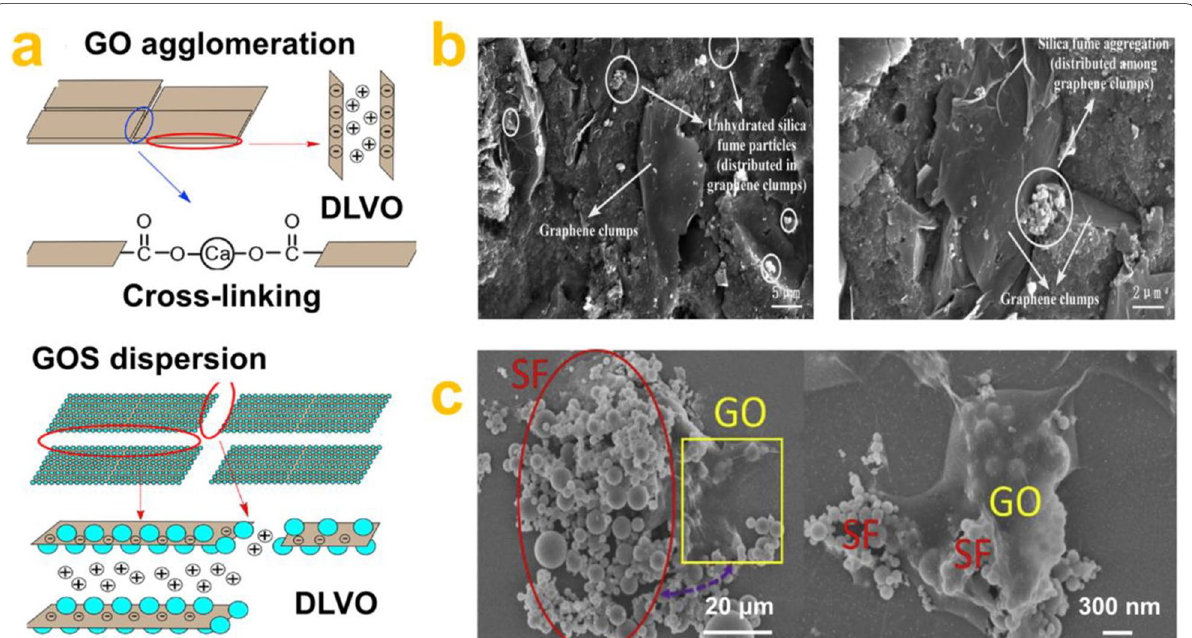
Fig. 5 Schematic of GO-SiO 2 nanohybrids (GOS) dispersion [105]. (Copyright 2020 Elsevier). b SEM image of the graphene-silica fume dispersion in cement matrix [114]. (Copyright 2018 Elsevier). And ( c ) SEM image of GO-silica fume dispersion [84]. (Copyright 2018